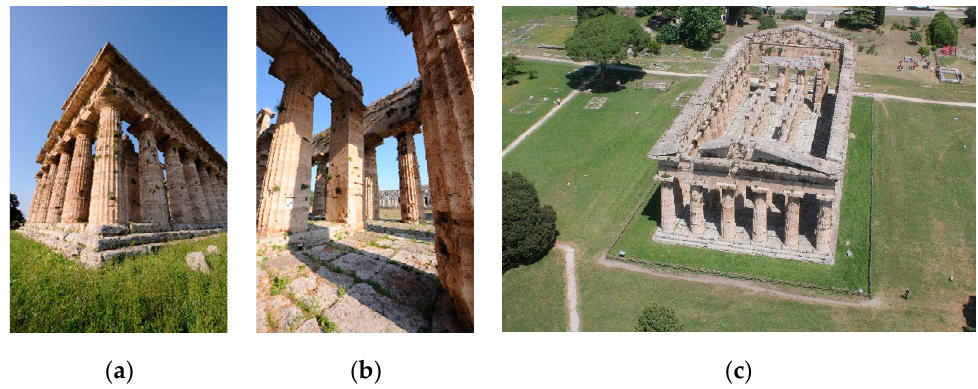
Figure 9. Some examples of the Nettuno temple dataset: terrestrial ( a ) and ( b ) and UAV ( c ) images.